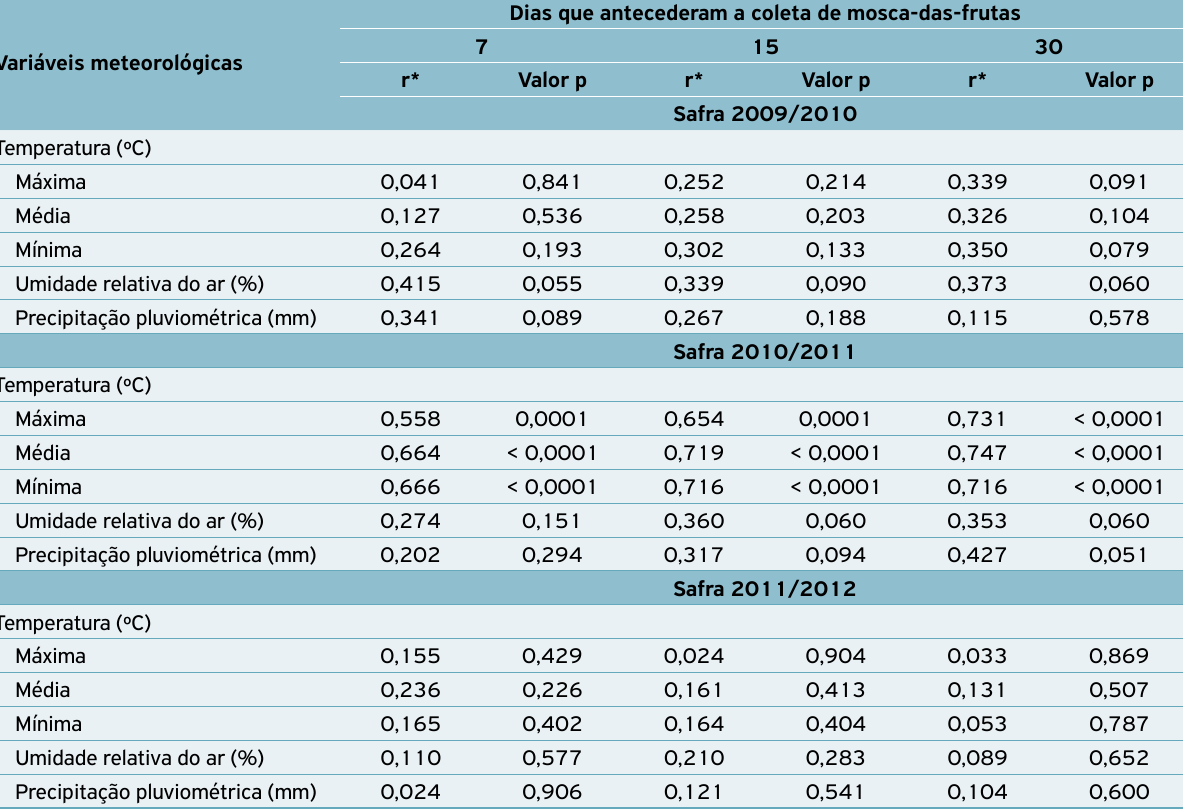
Tabela 1. Correlação entre o número médio de Anastrepha fraterculus (Diptera: Tephritidae) e as variáveis meteorológicas,